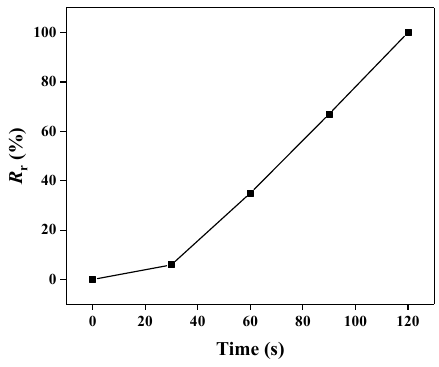
Figure 8. The plot of shape recovery ratio ( R r ) versus recovery time.